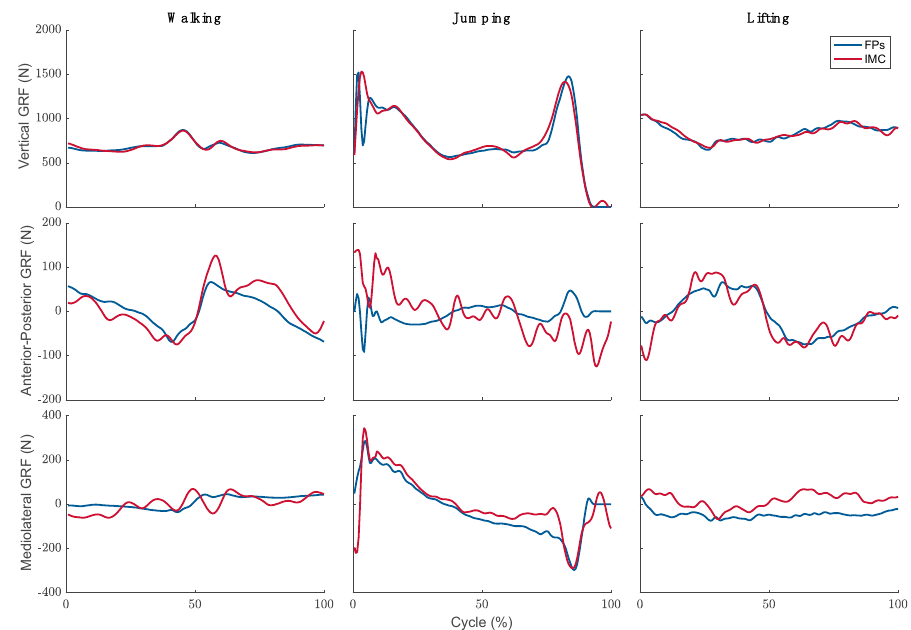
Figure 5. Typical examples of the FP measured (blue line) and IMC predicted (red line) vertical, anterior-posterior, and mediolateral components of the total GRF during walking, jumping, and lifting.